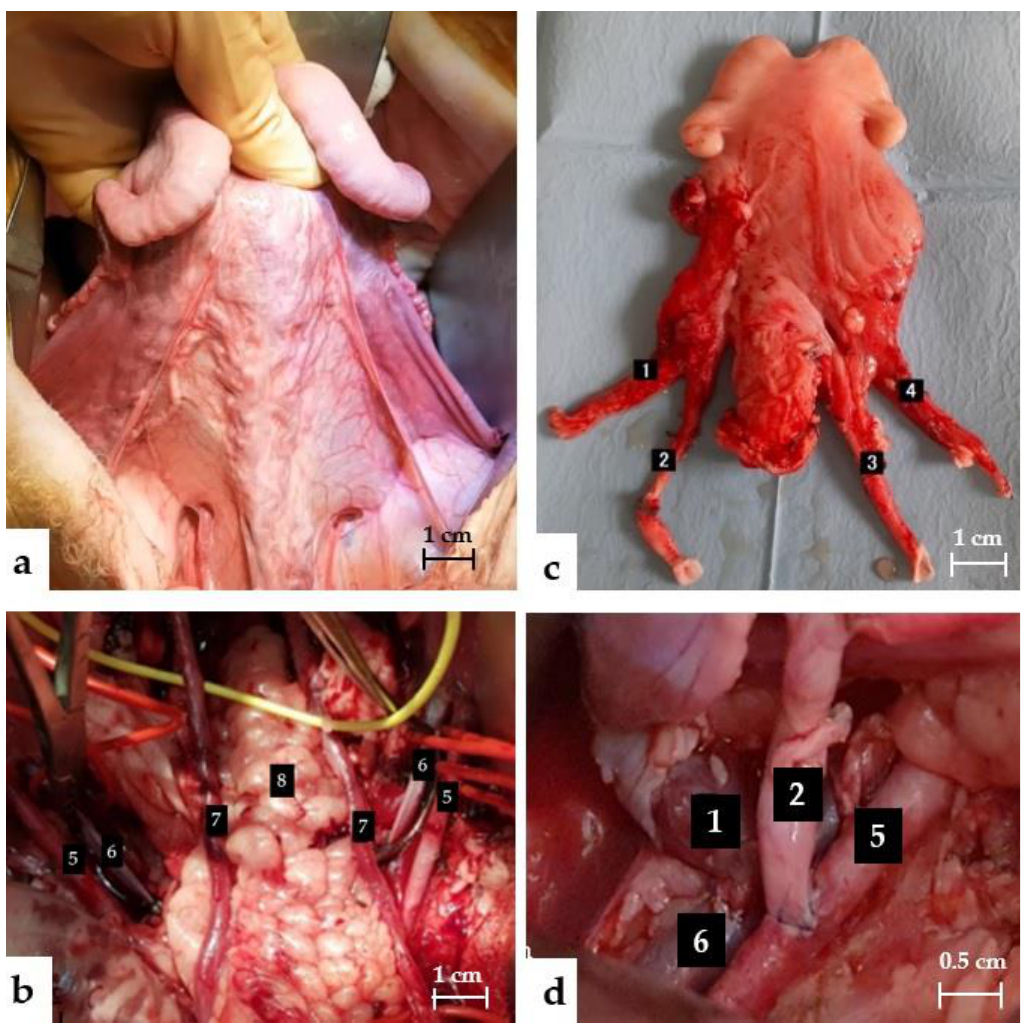
Figure 4. ( a ) Anterior view of the uterus before the dissection. ( b ) Pelvic view before anastomoses. ( c ) Posterior uterine view on the back table. ( d ) End of the anastomoses. 1 Left uterine vein, 2 left uterine artery, 3 right uterine artery, 4 left uterine vein, 5 external iliac artery, 6 external iliac vein, 7 ureter, 8 rectum.